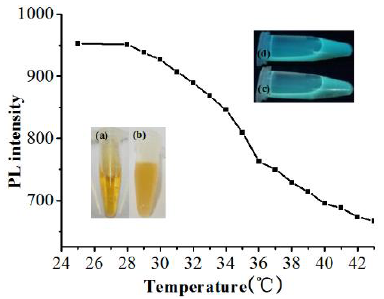
Figure 8. The diagram of fluorescence intensity of CDs/PNIPAM with different temperatures. ( a ) 25 °C under daylight; ( b ) 40 °C under daylight; ( c ) 25 °C under ultraviolet; ( d ) 40 °C under ultraviolet.